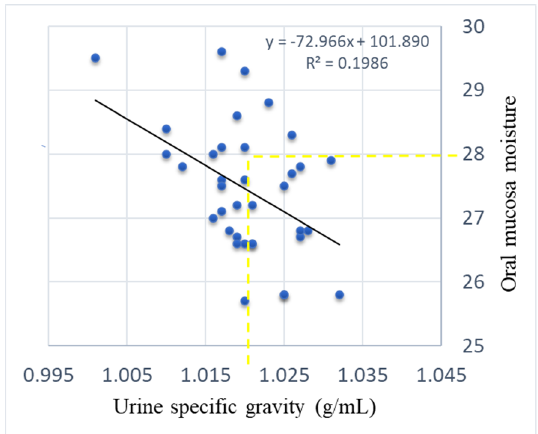
Figure 4. A scatter plot of the oral mucosa moisture and urine specific gravity for both the summer and winter camps. The oral mucosa moisture had a moderate negative correlation with urine specific gravity ( p < 0.05, r = − 0.45). The regression equation showed that the value of oral mucosa moisture predicting urine specific gravity of 1.020 g/mL, which is an index of dehydration, was ≈27.5.